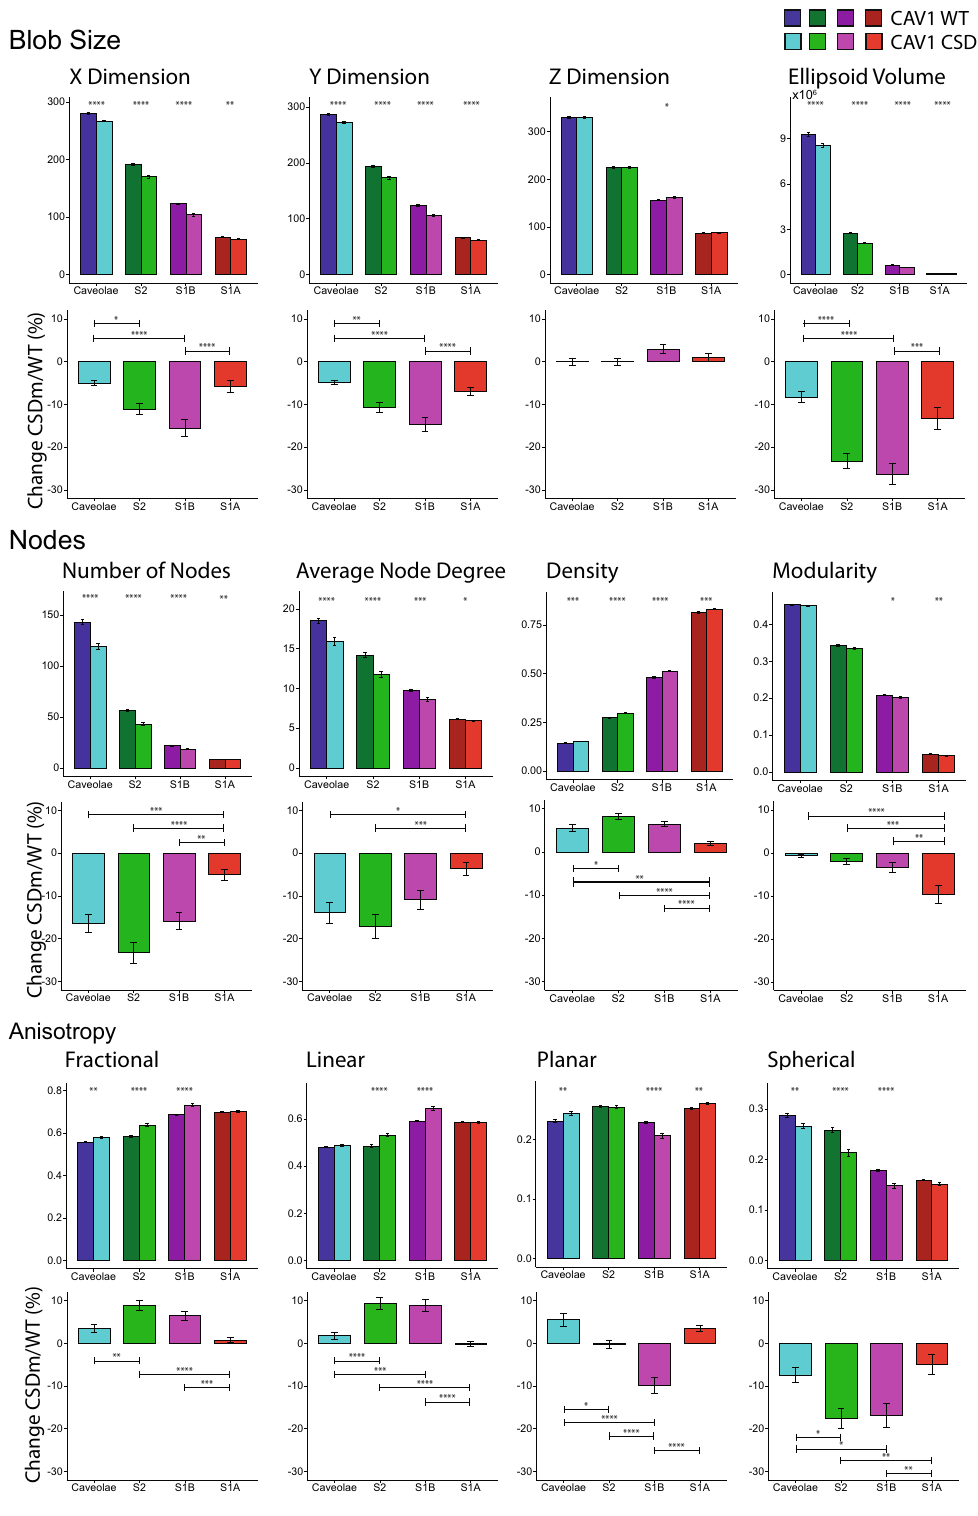
Figure 5. Changes in features of each class of CAV1 blobs. Bar graphs depicting changes in blob size, number of nodes, and anisotropy with respect to each class of blobs in CAV1 WT and CSD mutant (two-tailed unpaired t test; * p < 0.05; ** p < 0.01; *** p < 0.001; **** p < 0.0001). Percent change of the features between CSD mutant and CAV1 WT (ANOVA with Tukey post-test; * p < 0.05; ** p < 0.01; *** p < 0.001; **** p <